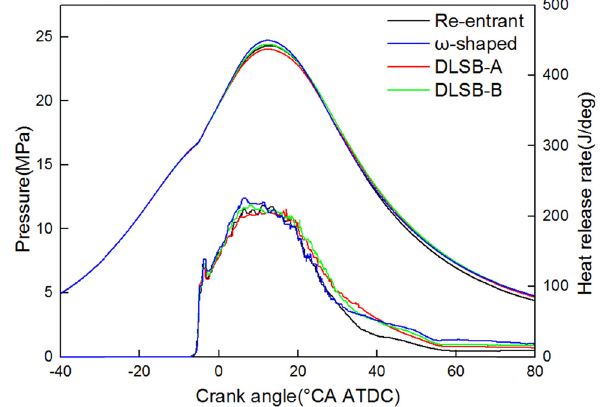
Figure 8: In - cylinder pressure and heat release rate traces under di ff erent piston